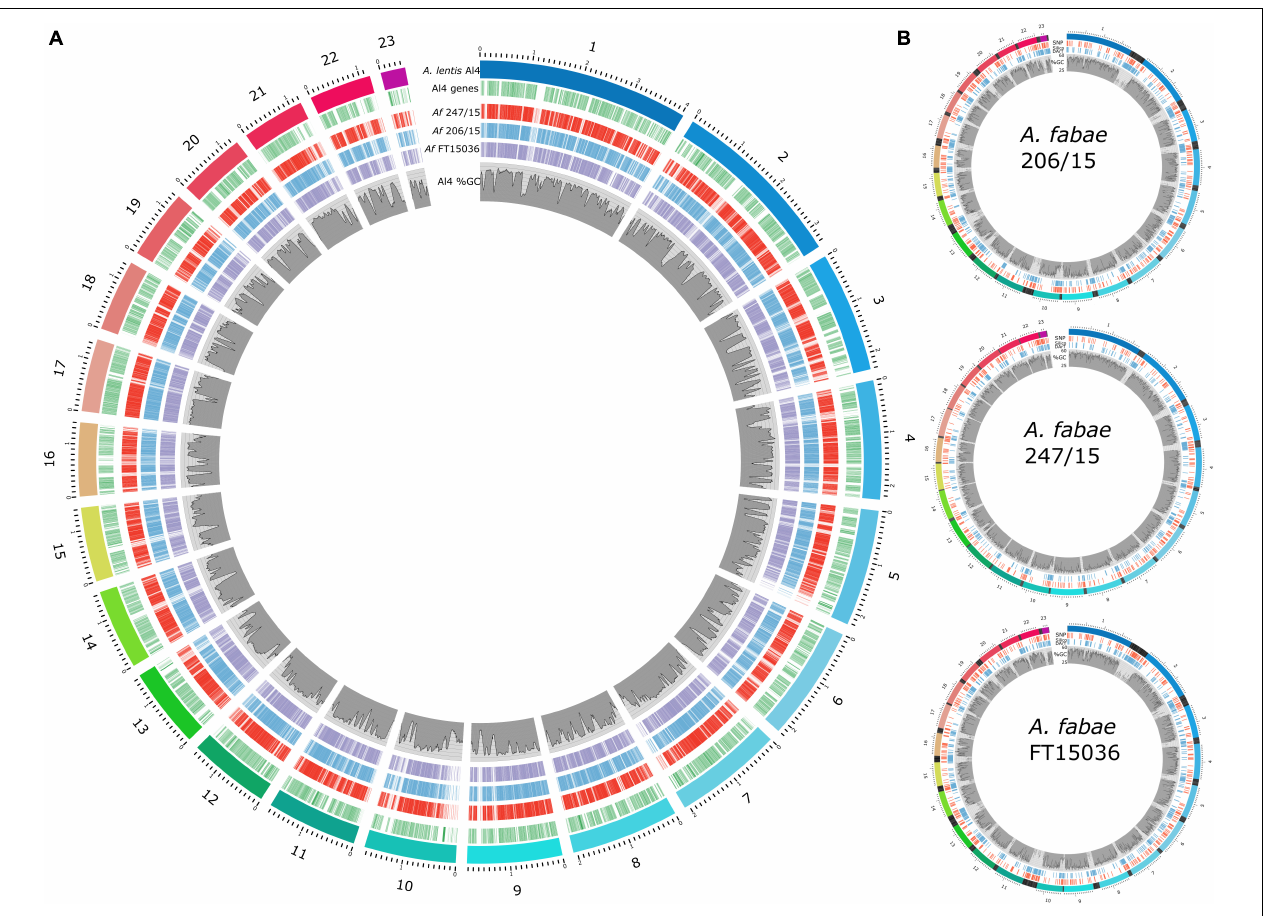
FIGURE 5 | Ascochyta fabae genome sequencing. (A) Comparison of A. fabae genome assemblies with the published near-complete A. lentis assembly. Coverage of A. fabae RagTag genome assemblies aligned to the A. lentis Al4 reference genome, shown as red (247/15), blue (206/15), and purple (FT15036) blocks. A. lentis genes (green bars) and %GC content as previously published (Lee et al., 2021) are also shown. (B) Scaffolded A. fabae assemblies for isolates, 206/15, 247-15, and FT15036, aligned using A. lentis Al4. Colored bands in the outer track for each plot represent RagTag contigs aligned to A. lentis chromosomes 1–23 using nucmer. Mapped positions of Diversity Arrays SNP (red) and SilicoDArT (blue) loci are indicated and %GC content for respective RagTag A. fabae scaffolds (1–23) is plotted. Blocks of black bands in the outer tracks represent A. fabae contigs not included in the large RagTag scaffolds but aligned to the preceding A. lentis scaffold in the nucmer